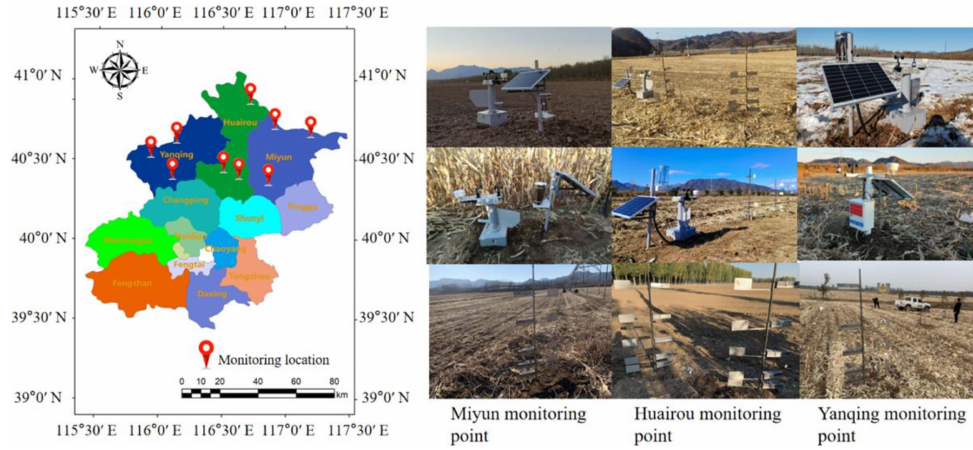
Figure 1. Location and mode diagram of test